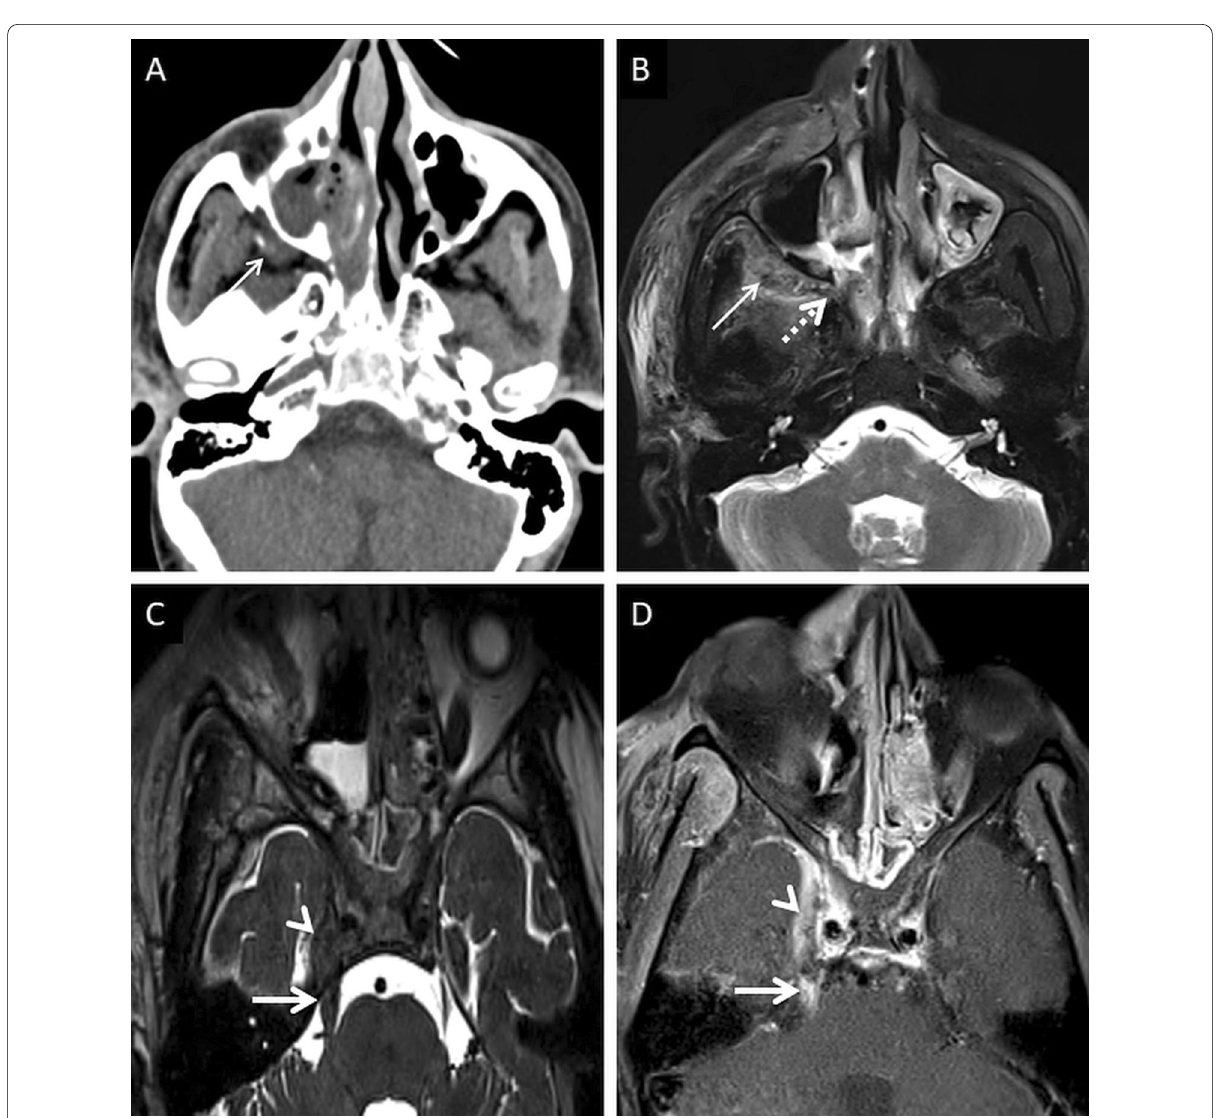
of the right trigeminal nerve (thick arrow). Note the lateral convexity of the right cavernous sinus (arrow head). CE FS T1W image ( d ) reveals dural the right trigeminal nerve (thick arrow in d ) is also seen, suggestive of intracranial perineural